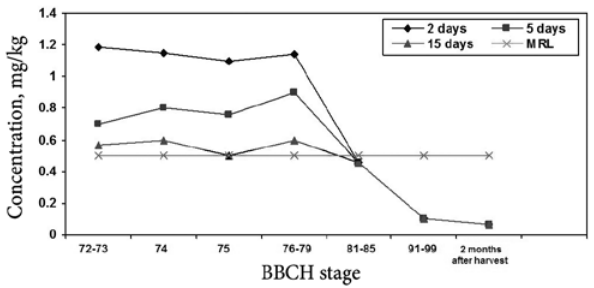
Fig. 7. Degradation of myclobutanil in Jonathan apples